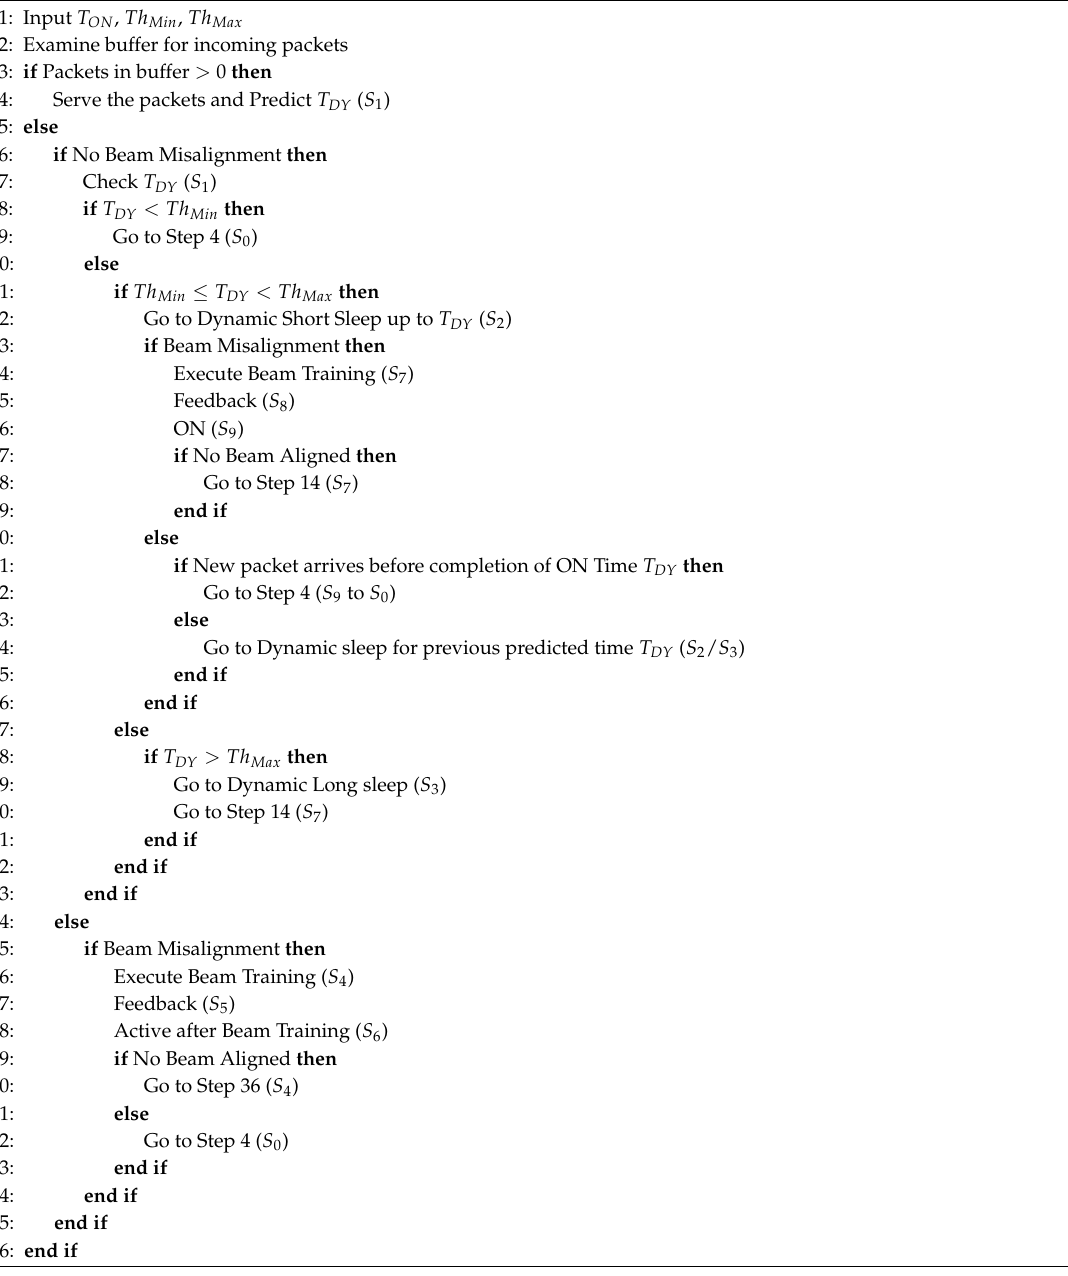
Algorithm 1 AI based DRX for Multiple Beam